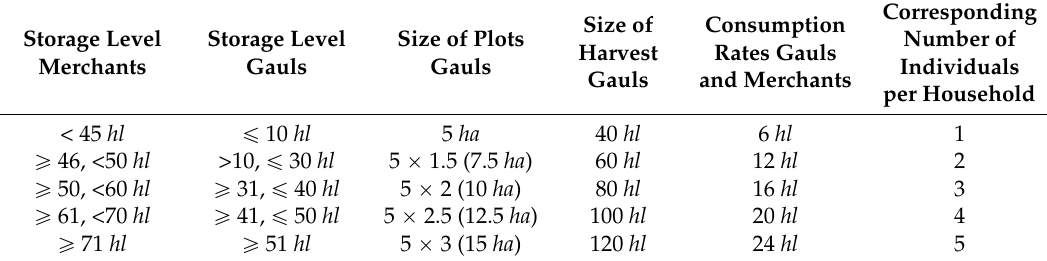
Table 1. How storage level affects the number of individuals in a household and their consumption rates. This enables agents to increase their family size, and thus the productivity of their land, as well as increasing the ability to trade. However, once an agent trades, its storage level will be cut in half (as half is donated to the daughter household) decreasing the household size in the process. Merchants have a higher storage level because they cannot grow their own food, and thus need to plan more to be able to raise daughter